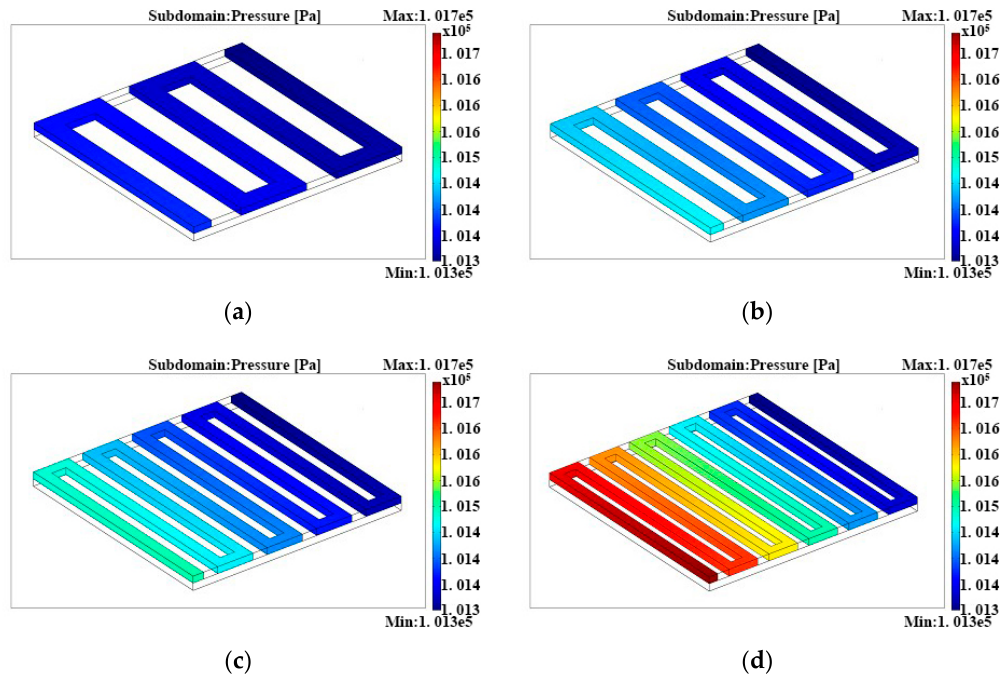
Figure 7. Pressure distributions in the anode serpentine flow fields with different channel lengths: ( a ) channel length = 47.32 mm, ( b ) channel length = 63.50 mm, ( c ) channel length = 79.60 mm, and ( d ) channel length = 96.03 mm.